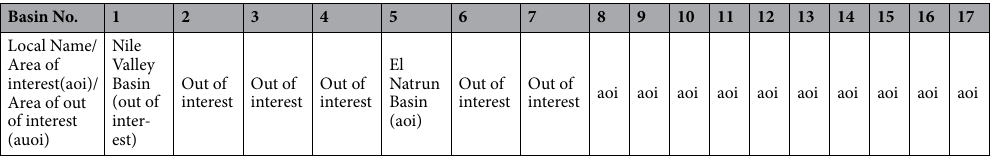
Table 1. Summary of interest/out of interest investigated areas (basins).